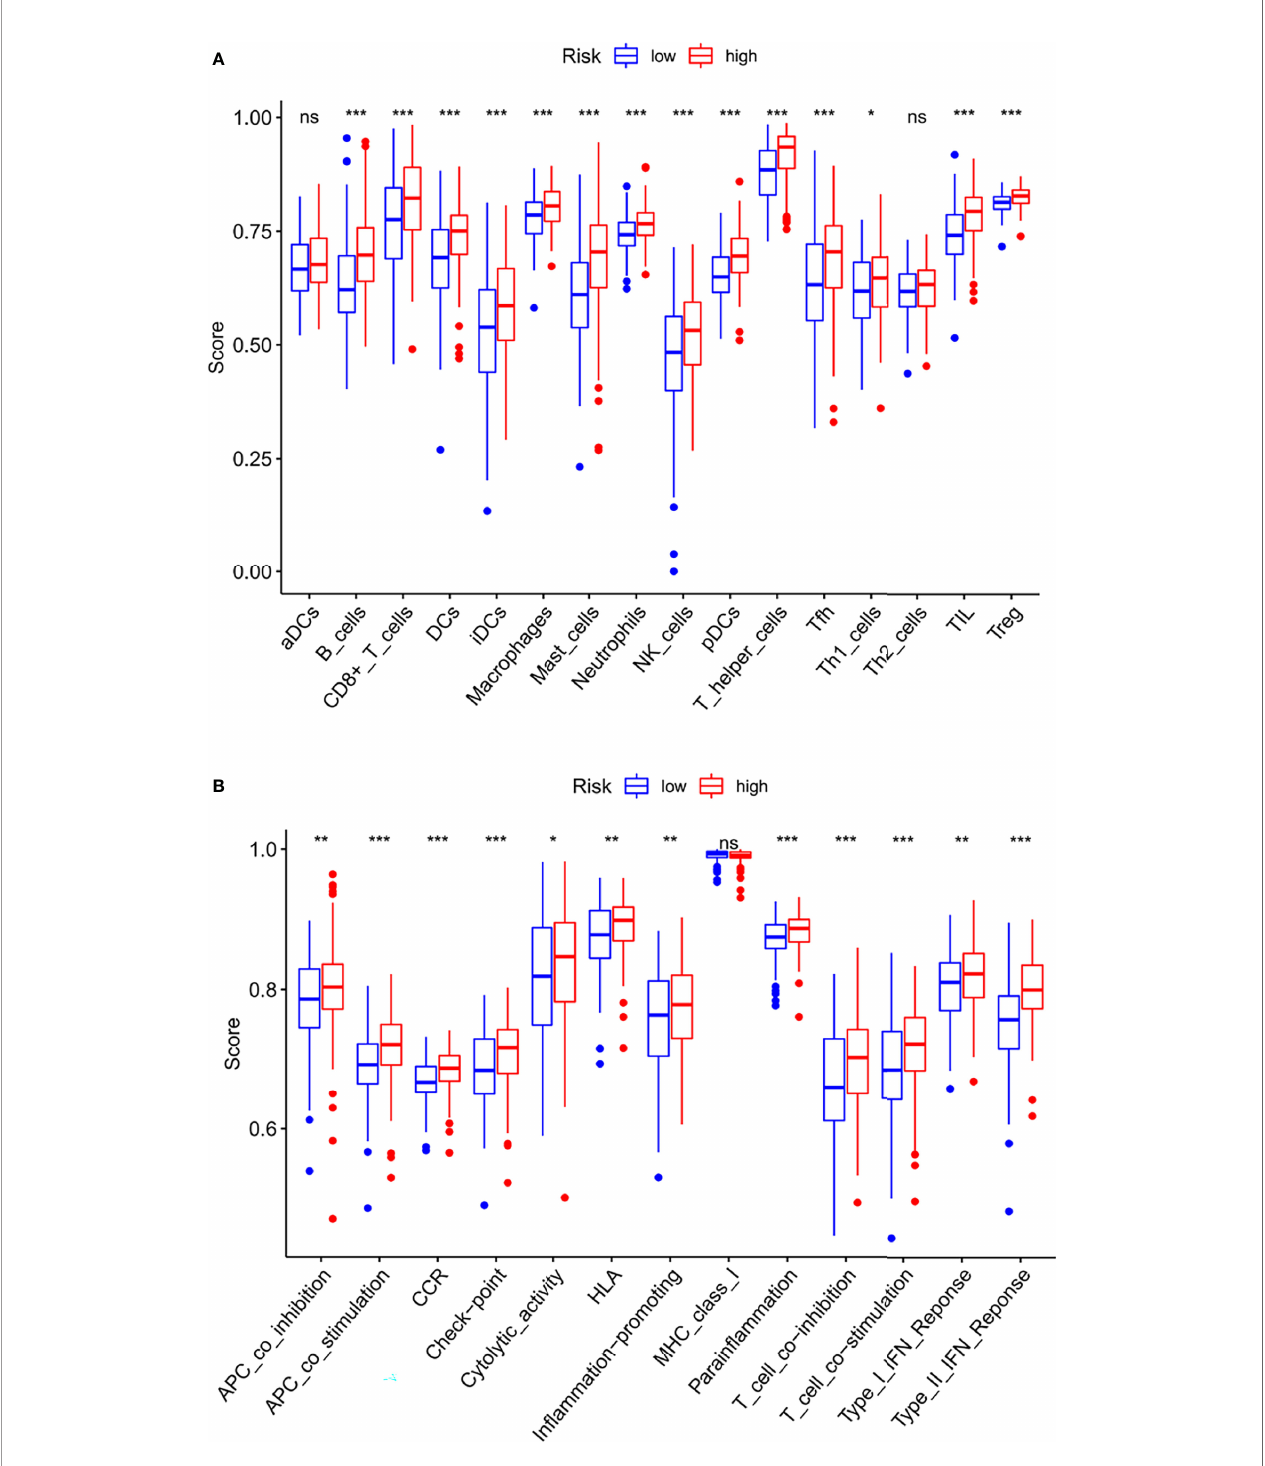
FIGURE 7 | Relationship between IFRSig and immune in fi lration immune function. (A) Box plot showing association between IFRSig and Immunoin fi ltrating cells. (B) Box plot showing association between IFRSig and immune functions. NS No Signi fi cance, *p < 0.05, **p < 0.01, ***p <